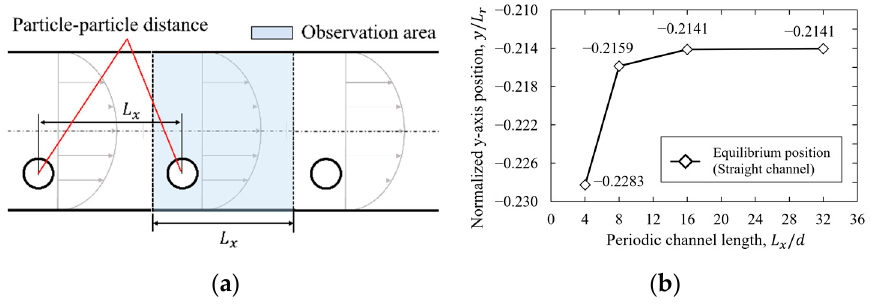
Figure 5. Examination of periodic length. ( a ) Schematic of relationship between particle-particle distance and periodic length. ( b ) Relationship between equilibrium position of particle and periodic length with 𝑙 = 200 cells , 𝑅𝑒 = 27.54 , and 𝐶 = 0.25